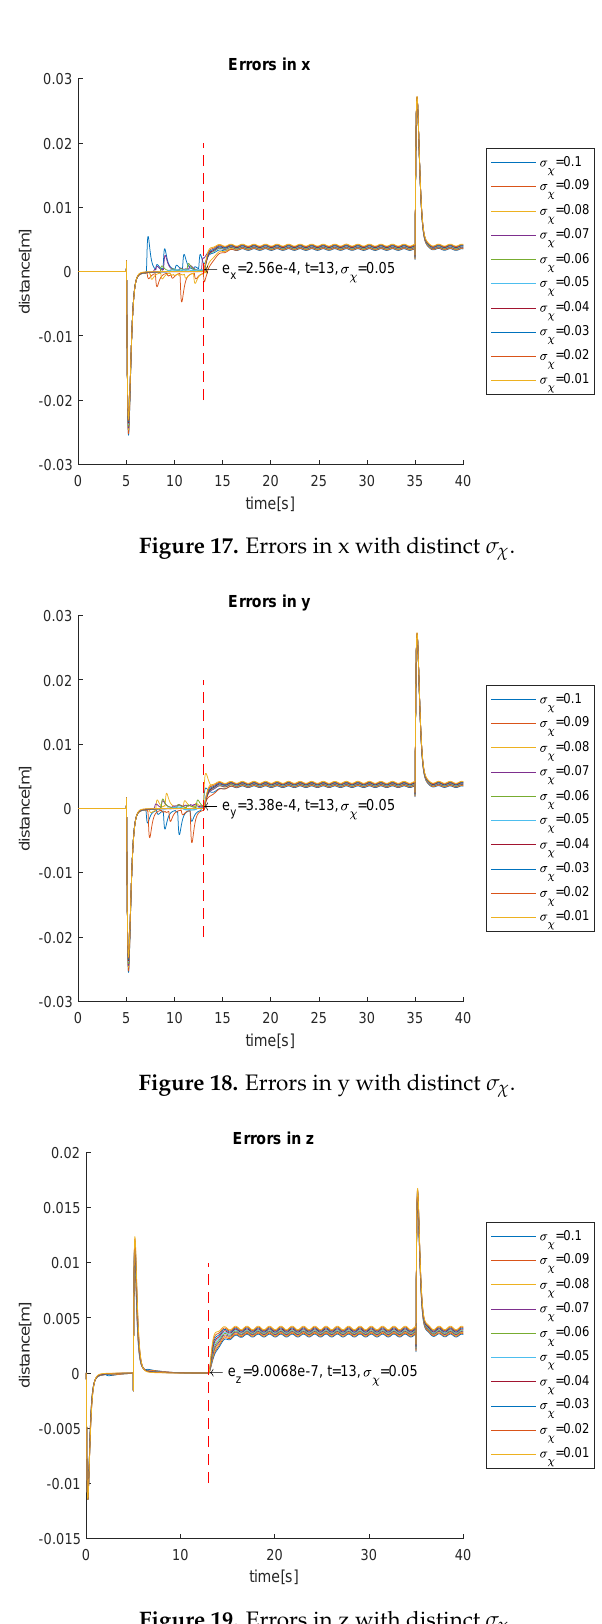
Figure 19. Errors in z with distinct σ χ